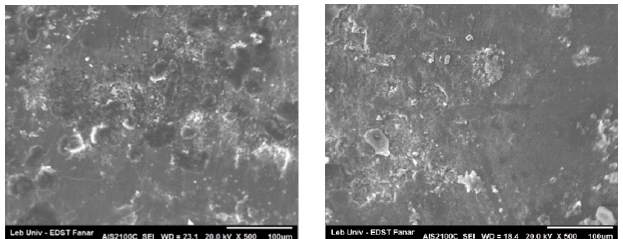
Figure 8. SEM figures of enamel topography debonded by Er,Cr:YSGG subgroups.